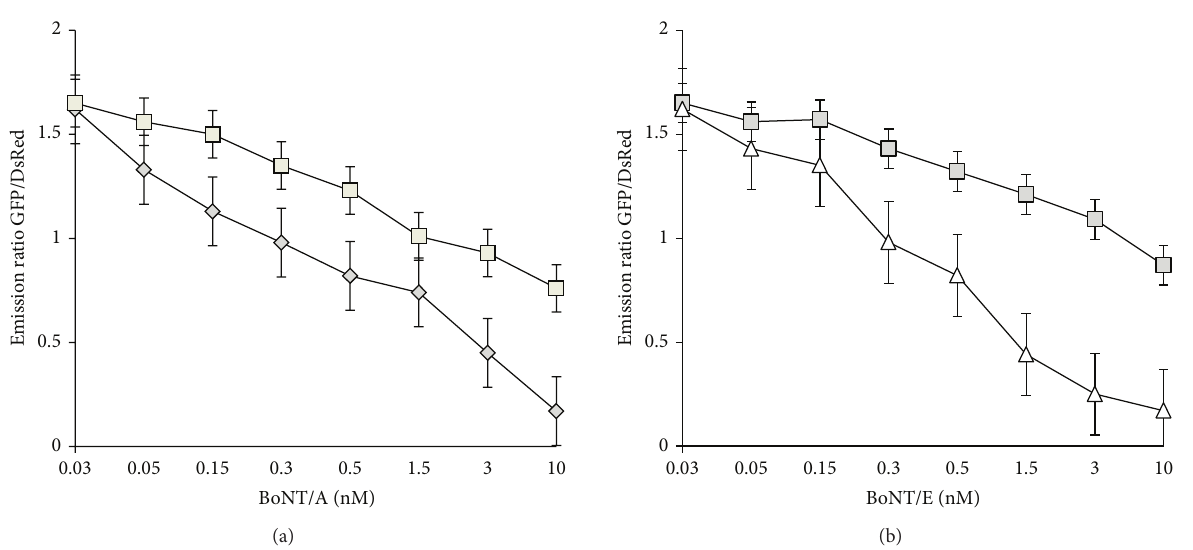
Figure 5: (a) BoNT/A complex activity and comparison with BoNT/A holotoxin. Clone 5A3 cells were subjected to assay protocol to test the activity of BoNT/A holotoxin and complex toxin. PC12 cells were grown in 96 well plates in the presence of indicated BoNT/A holotoxin ( ⬦ ) and complex toxin ( ◻ ) at 0.03, 0.05, 0.15, 0.3, 1.5, 3.0, and 10nM concentrations. Data are presented as means ± SD ( 𝑛 = 3 ). The fluorescence measurements were performed by BioTek microplate reader. (b) BoNT/E complex activity and comparison with BoNT/E holotoxin. Clone 5A3 cells were subjected to assay protocol to test the activity of BoNT/E holotoxin and complex toxin. PC12 cells were grown in 96 well plates in the presence of indicated BoNT/E holotoxin ( △ ) and complex toxin ( ◻ ) at 0.03, 0.05, 0.15, 0.3, 1.5, 3.0, and 10nM concentrations. Data are presented as means ± SD ( 𝑛 = 3 ). The fluorescence measurements were performed by BioTek microplate